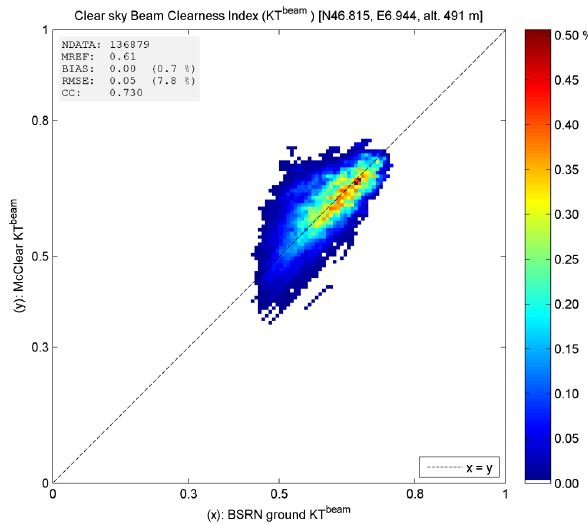
Fig. 7. Scatter density plot between BSRN 1min clear-sky data and McClear. Payerne. Beam clearness index